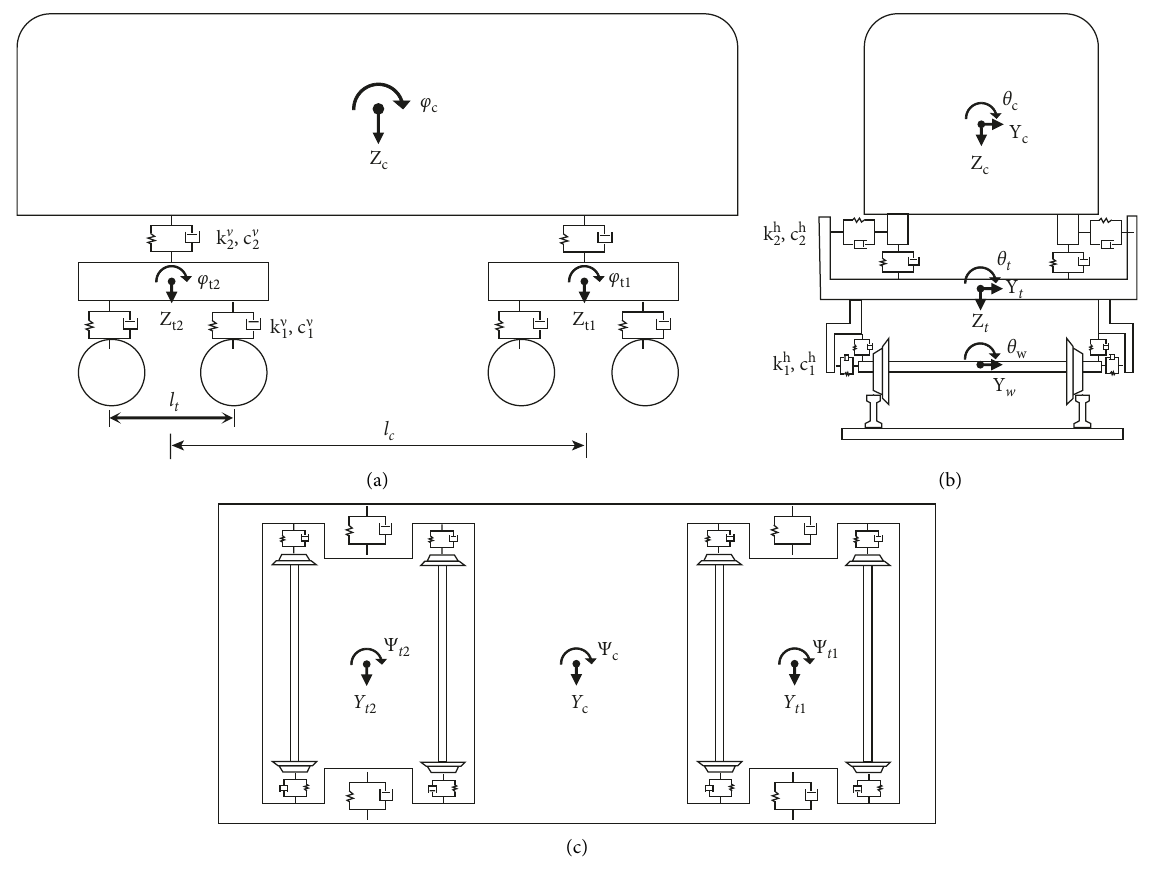
Figure 6: Vehicle model: (a) right view. (b) Rear view. (c) Bottom view. Table 2: The main parameters of the vehicle